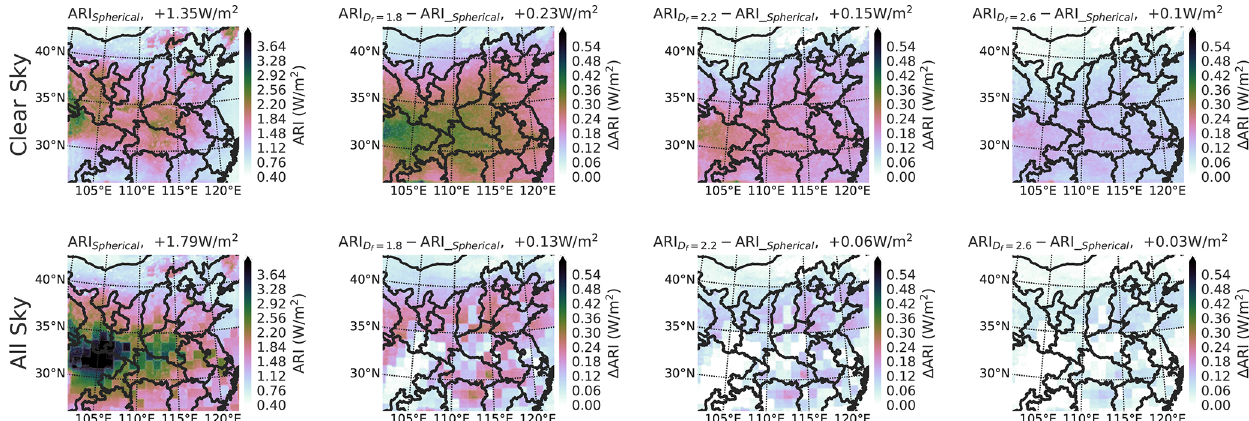
Figure 14. The regional-mean BC ARI at the TOA in eastern China for different particle models.